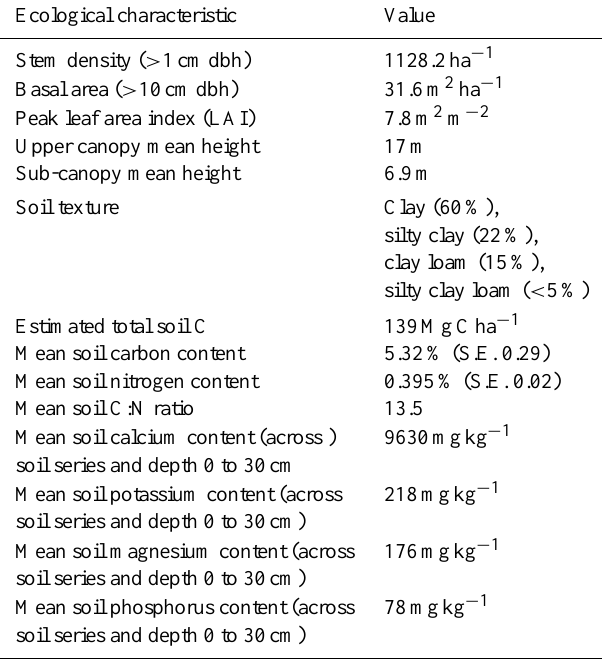
Table 2. Study area stand ecological characteristics, based on an 18ha plot. The tower is located towards the northern end of this plot (summarised from Butt et al., 2009).